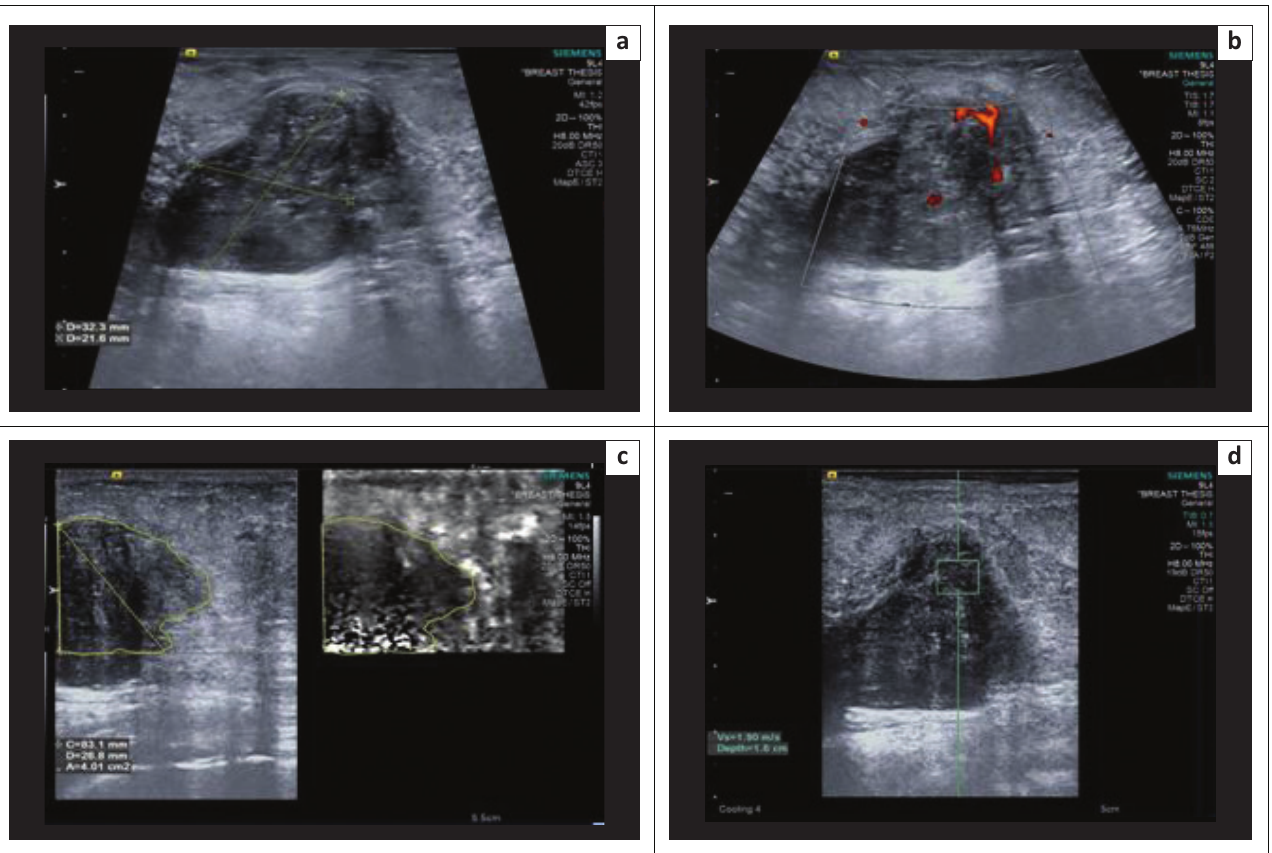
FIGURE 6: (a, b) B-mode ultrasonography demonstrating an oval, lobulated, taller than wide, heterogeneously hypoechoic lesion with internal vascularity on power Doppler, indicating a Breast Imaging Reporting and Data System 4 lesion; (c) elastogram indicating a relatively soft lesion with no obvious extension of the lesion into the adjacent parenchyma, with an area ratio < 1; (d) shear wave velocity in the lesion was 1.90 m/s. The final histopathology report was benign phyllodes